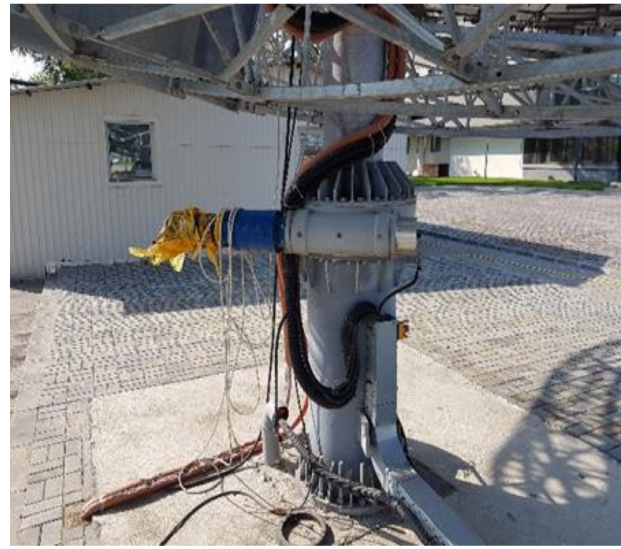
Figure 11. Solar concentrator support pylon.